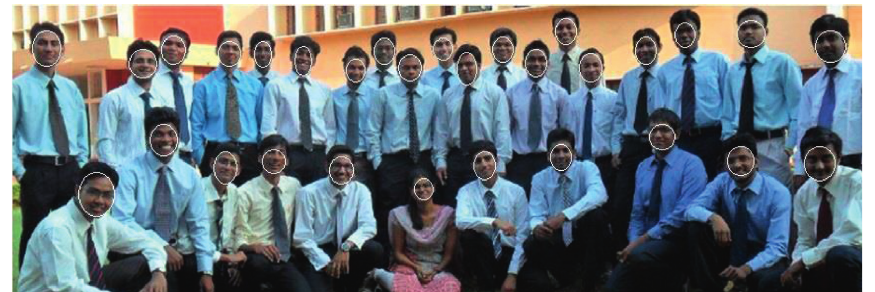
Figure 10: The detection results.